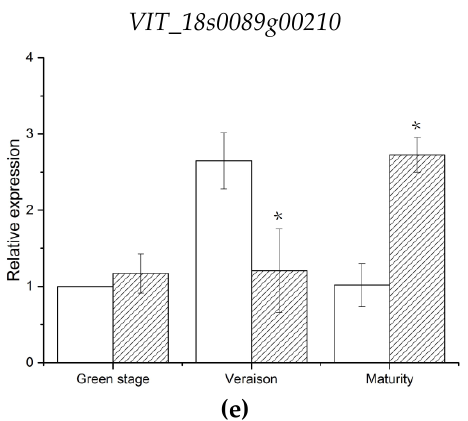
Figure 4. Changes in berry firmness ( a ) and qRT-PCR analysis of the expression of four candidate genes( b – e ) in parents at three fruit developmental stages. Asterisk indicates significant differences by t -test at p < 0.05. Data are the mean ± SD of three replications.